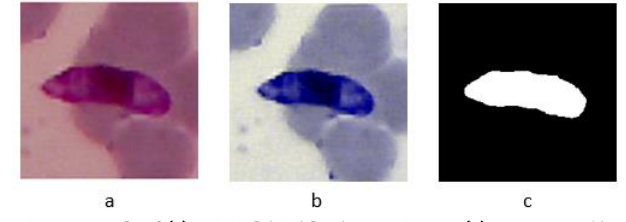
Fig. 1 Example of (a) Original thin blood smear image, (b) Preprocessed by [14], (c) Ideal